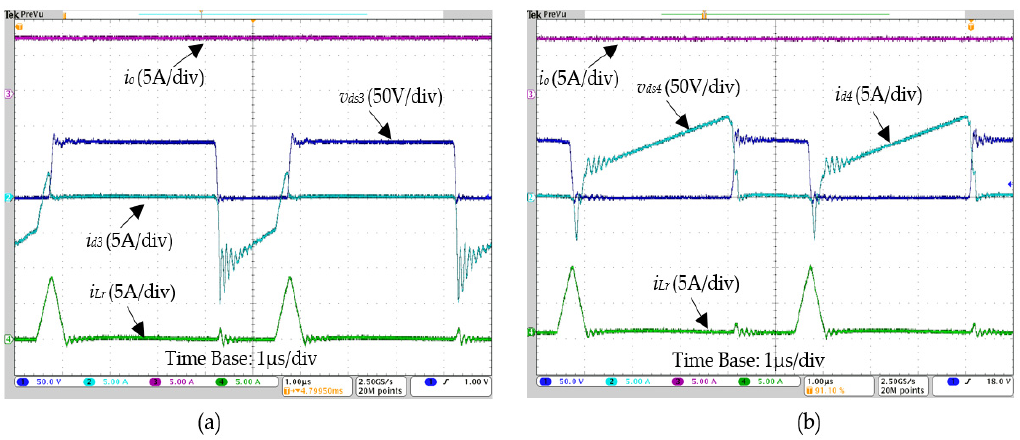
Figure 16. Experimental results of the current and voltage of the main switches when i o = 8 A. ( a ) S 3 ; ( b ) S 4 .